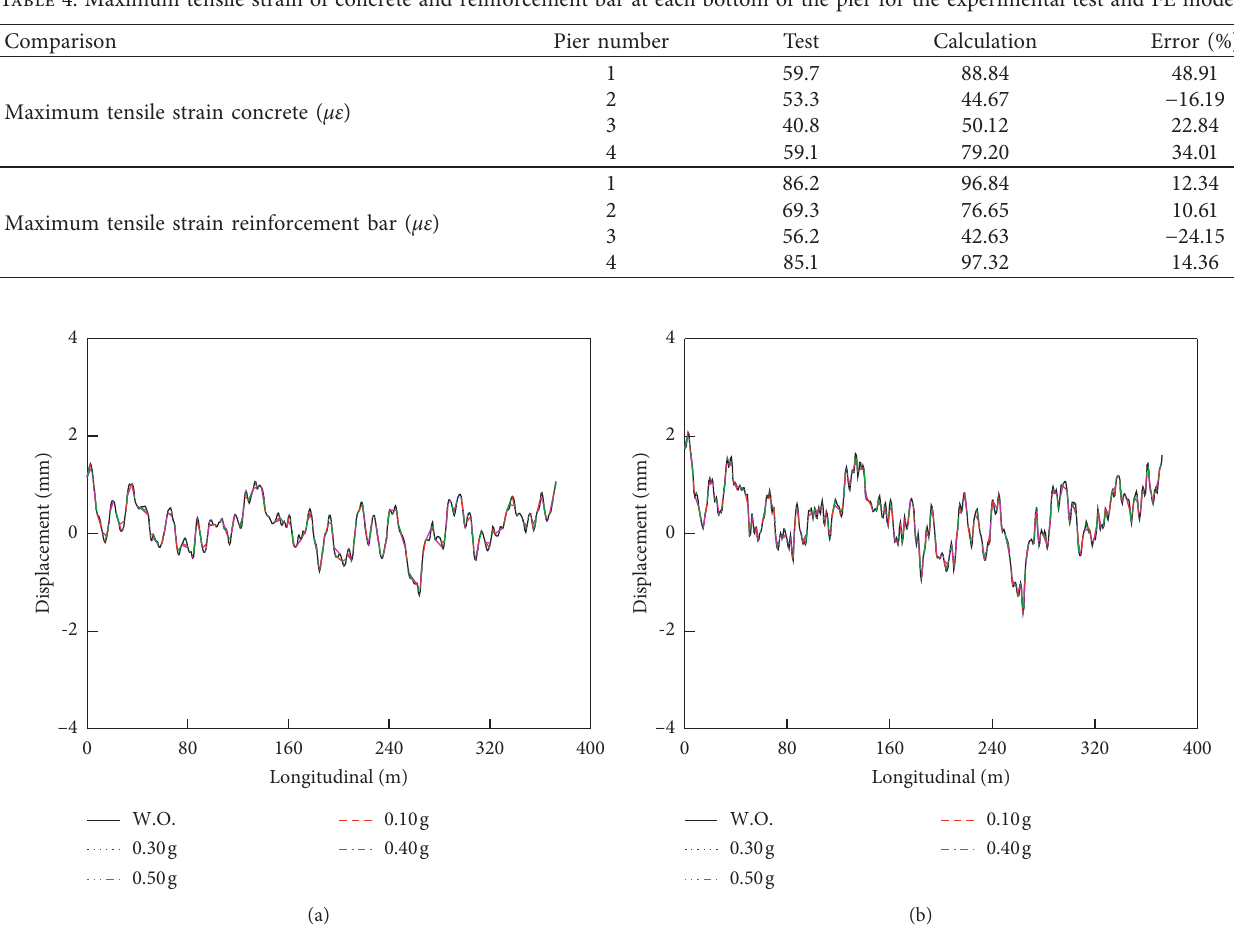
Figure 10: The comparison of displacement sample for (a) gauge and (b) cross irregularities.